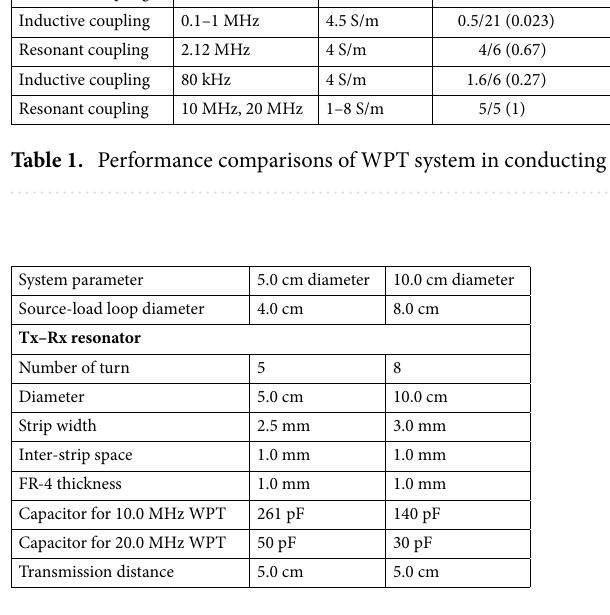
Table 2. Design parameters of WPT